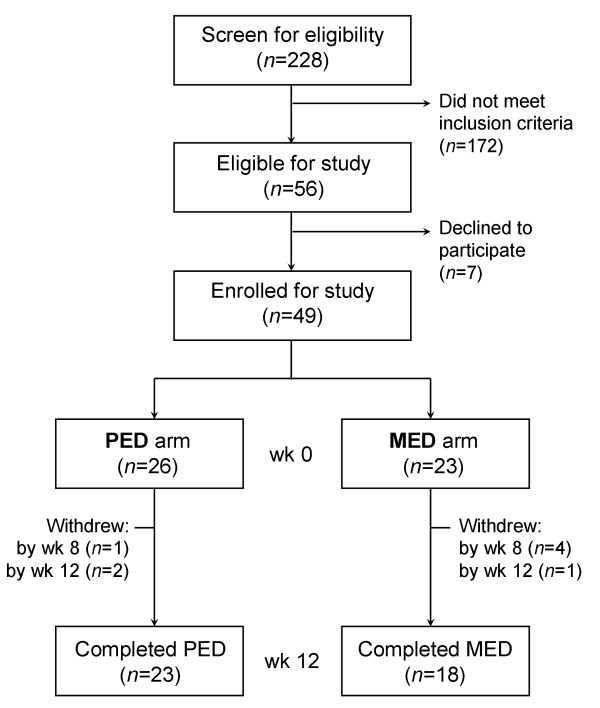
Flow chart of participant enrollment and study design.